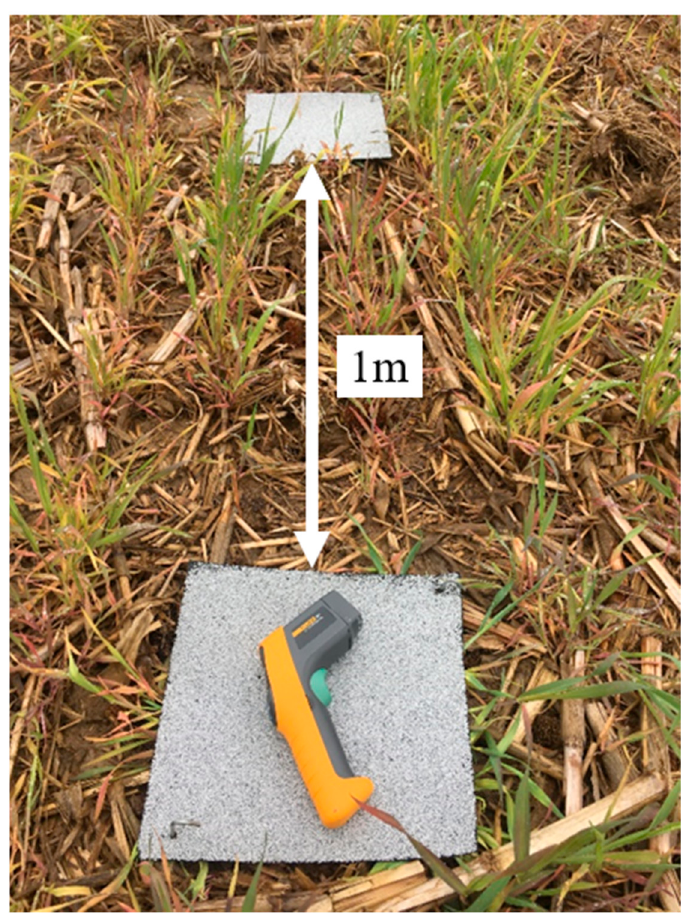
Figure 2. Paired traditional and modified refuge traps in cereal rye cover crop, 2019, and the infrared thermometer used for measuring temperature.